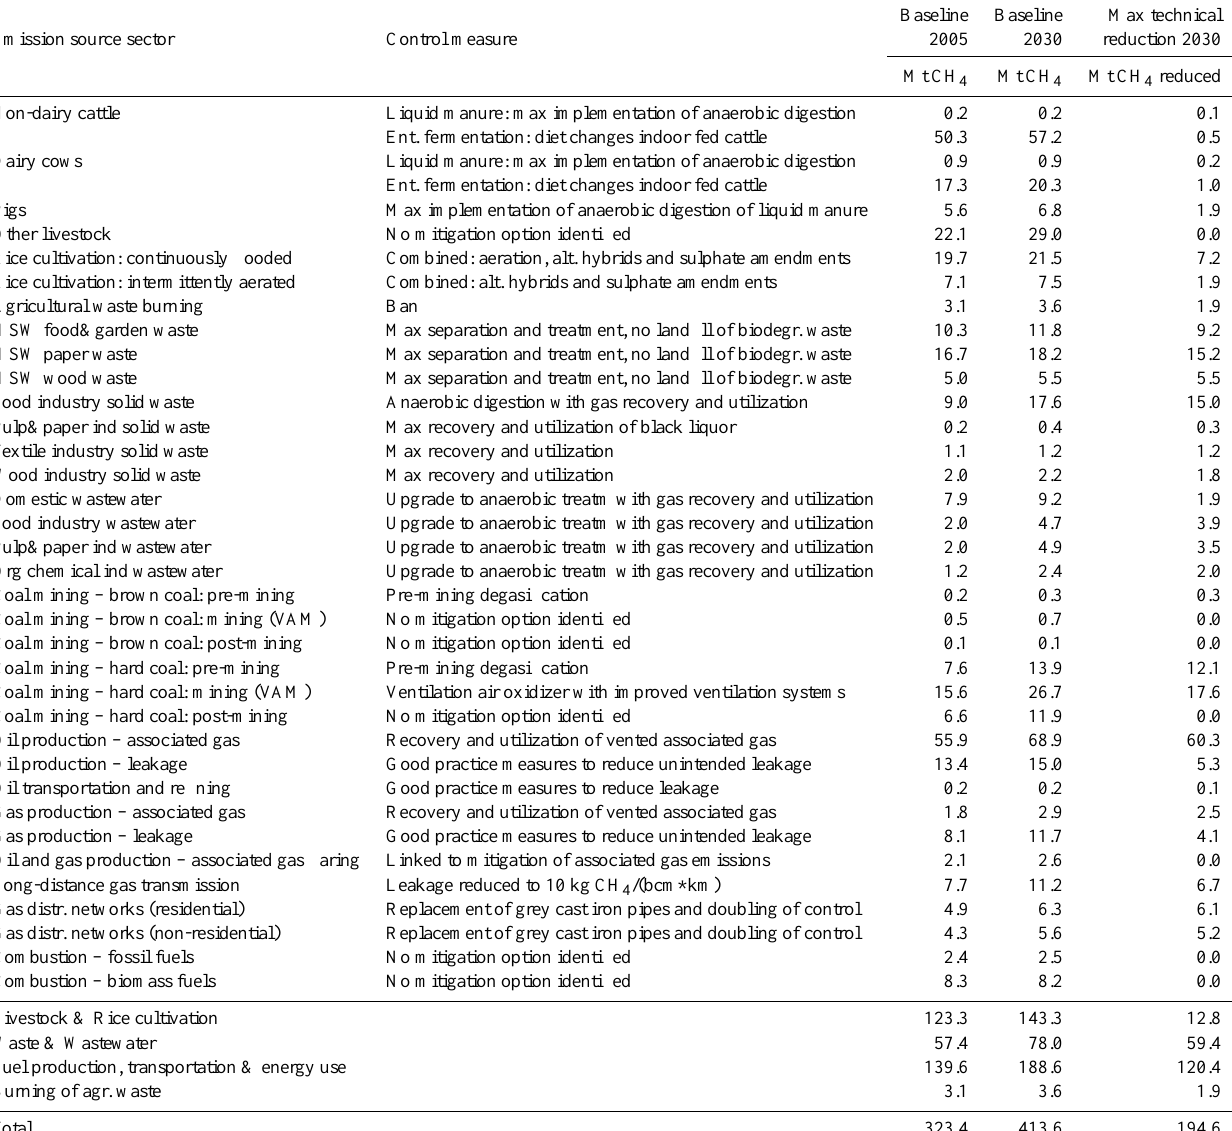
Table 6. Global CH 4 emissions and technical mitigation potentials in